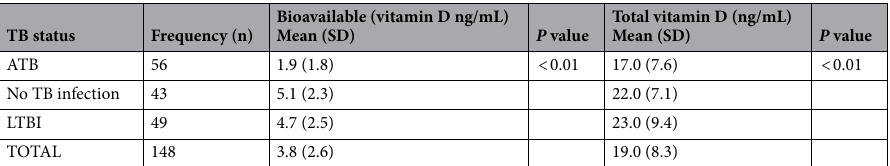
Table 2. Shows the mean bioavailable vitamin D levels among TB patients, LTBI, and those with no TB infection. SD standard deviation, LTBI latent TB infection.